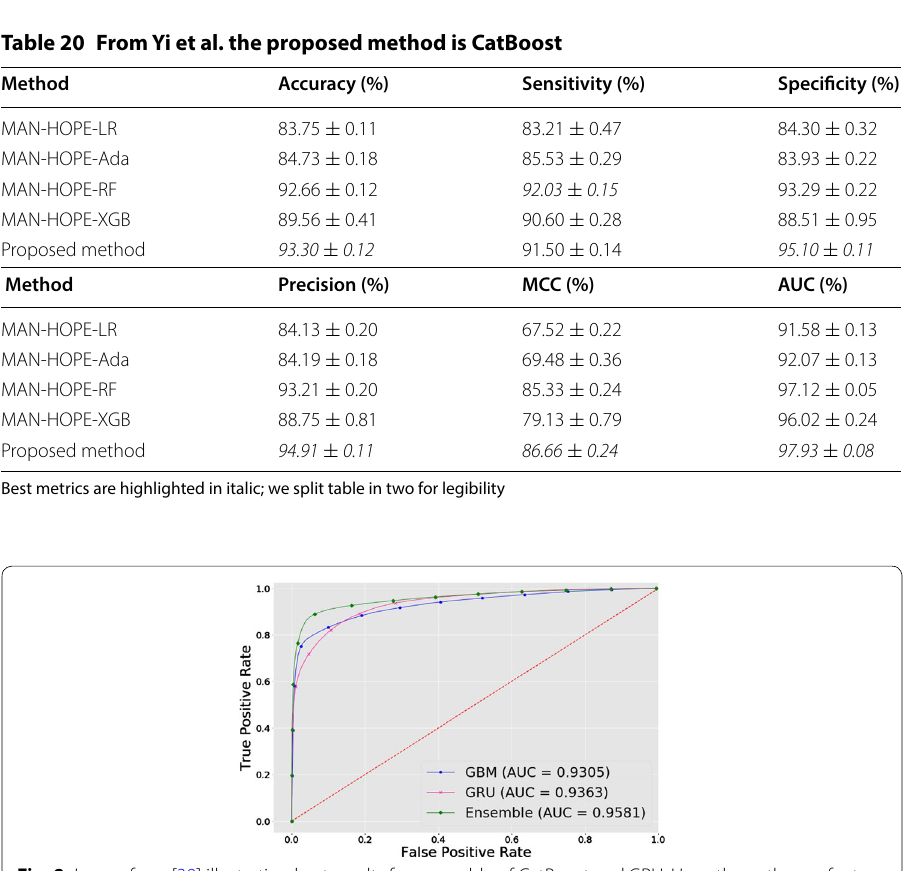
Table 20 From Yi et al. the proposed method is CatBoost